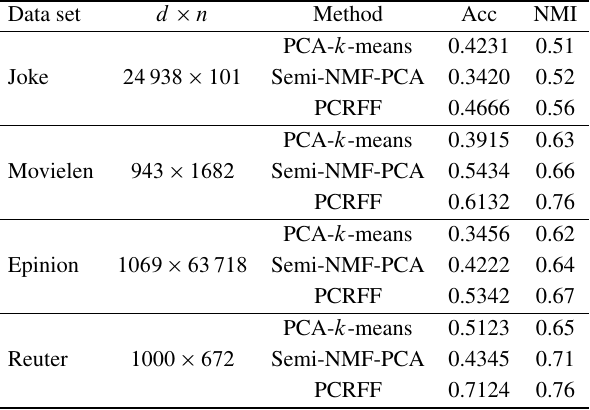
Fig. 7 NMI of different clustering methods by sampling percentage. Table 3 Performance comparison on different preference clustering